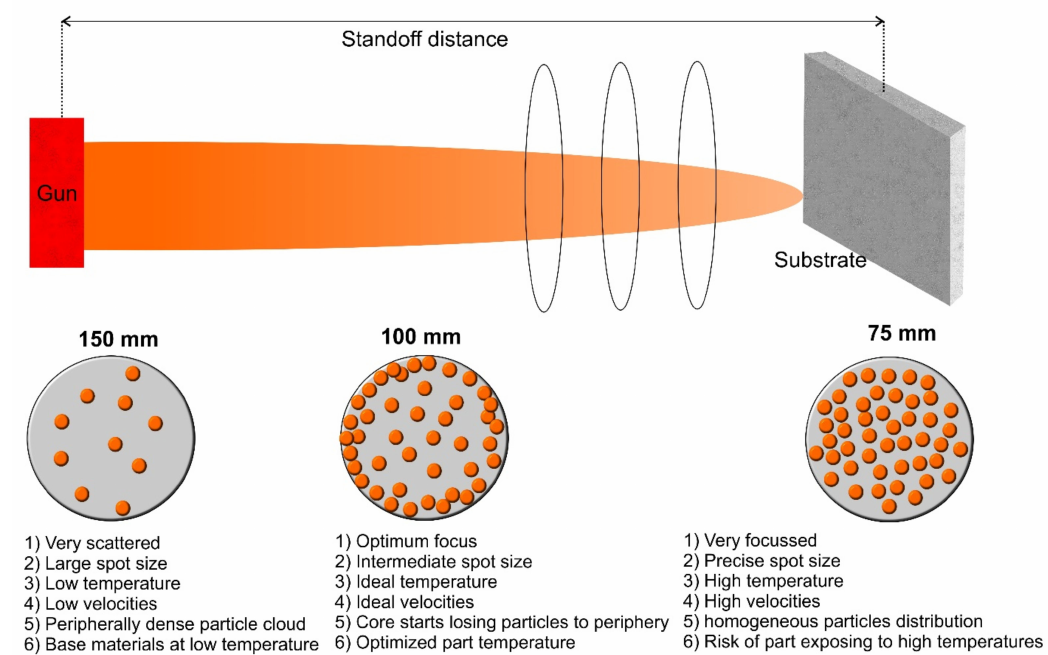
Figure 7. Plume plate picture and how to ensure deposition efficiency during thermal spraying